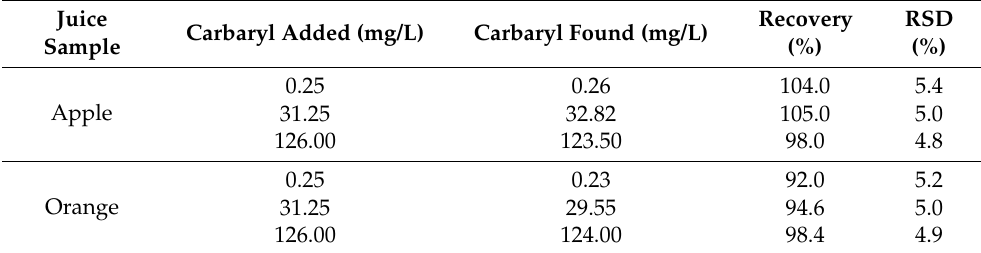
Table 2. Recovery study of carbaryl in freshly prepared apple and orange juices ( n = 3) in PBS (pH 6.86) with adsorptive accumulation time of 10 min and scan rate of 300 mV/s.